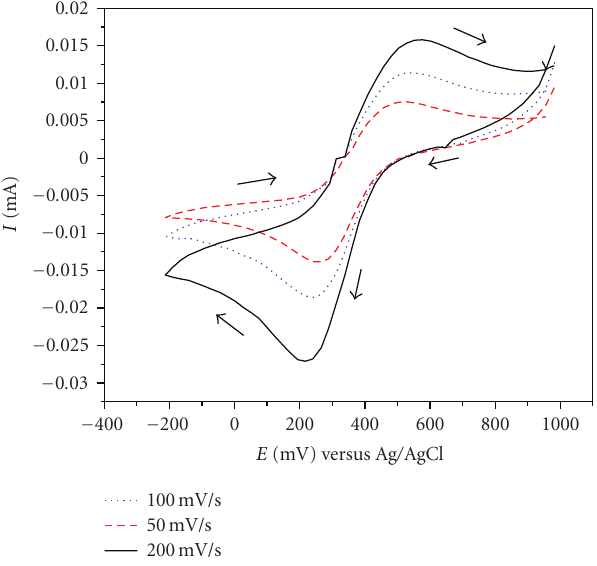
Figure 2: Cyclic voltammogram recorded at a glassy carbon electrode in CH 3 CN containing [Cu( bemims )(NO 3 ) 2 ] (2.9 10 − 2 M)